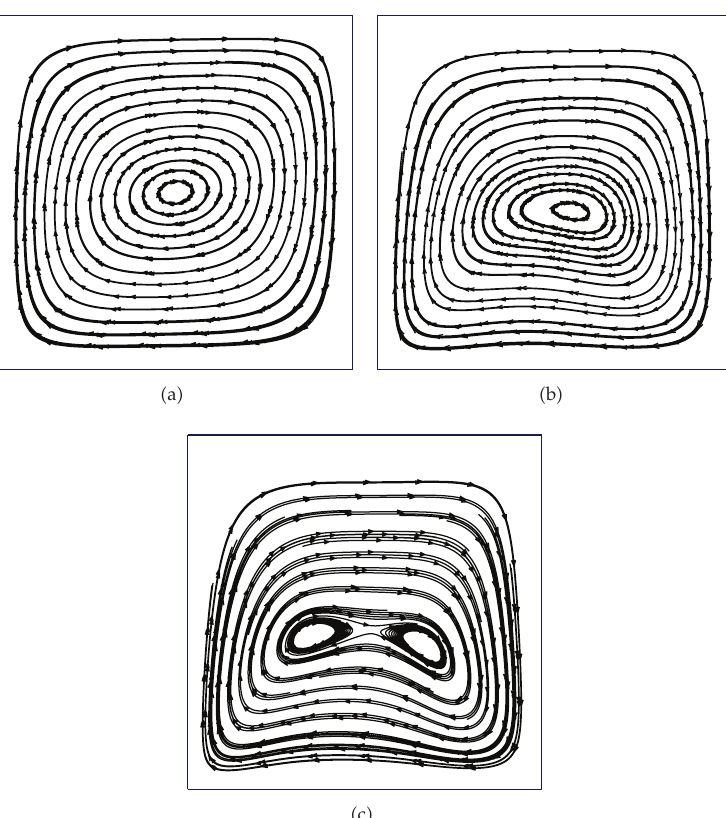
Figure 5: Streamlines for the thermomagnetic flow in a square cavity for Δ T (cid:8) 30K, Ra (cid:8) 10 4 : (cid:3) a (cid:4) m (cid:8) 0 . 0, (cid:3) b (cid:4) m (cid:8) 0 . 05, and (cid:3) c (cid:4) m (cid:8) 0 .